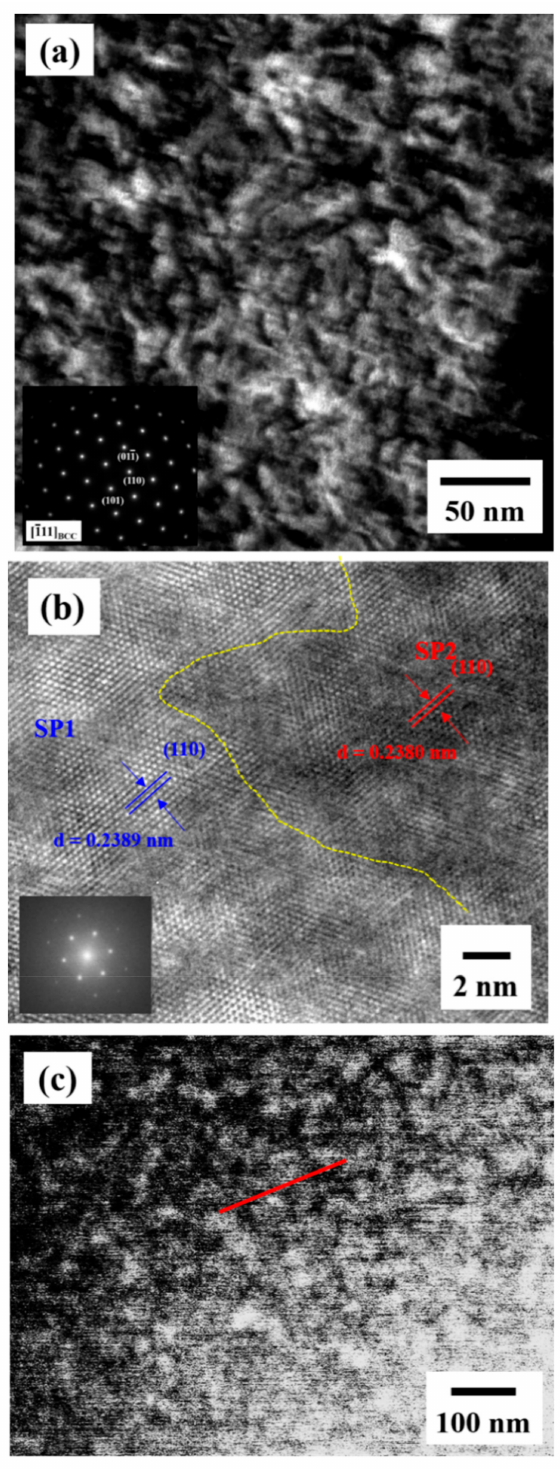
Figure 6. ( a ) The TEM dark-field images, ( b ) the corresponding high-resolution TEM images, and ( c ) the HAADF-STEM image of the interconnected structure in the as-homogenized